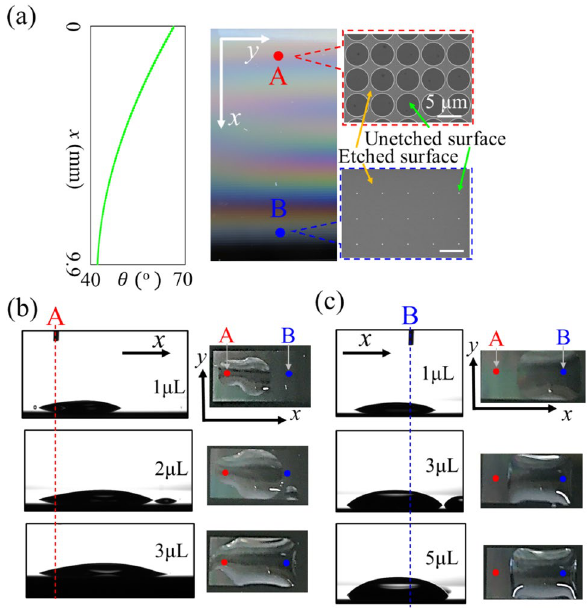
Figure 4. ( a ) Top-view photograph of the unidirectional fluid channel (center panel), SEM images around point A and B (right two panels), and the calculated contact angle on the x -axis (left panel). Side- and top-view photographs when repetitively dropping water from ( b ) point A and ( c )